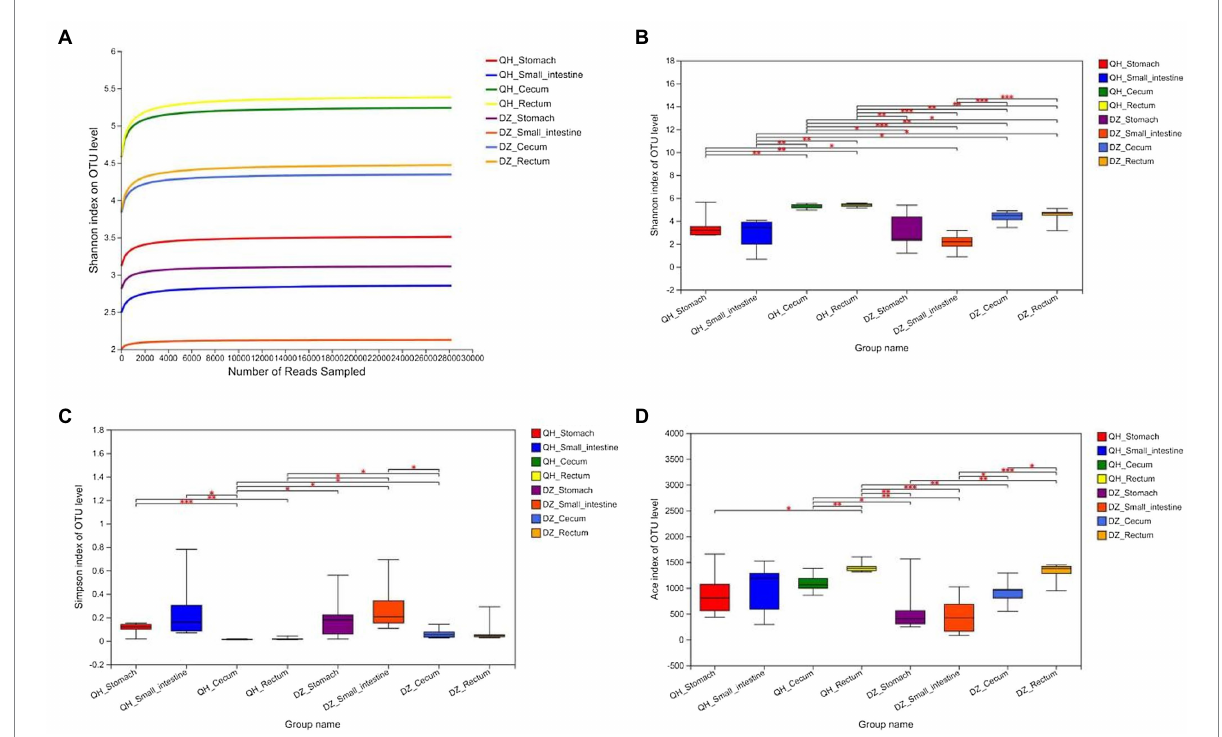
FIGURE 1 Alpha diversity analysis. (A) Sparse curve. Shannon’s exponential curve. The abscissa is the number of sequences; the ordinate is the OTU index. (B–D) Between-group t -test. Type I intervals represent the upper and lower limits of the index. The index difference test chart showed the significant difference between the selected two groups with significant differences (* p < 0.05, ** p < 0.001, *** p < 0.01), the abscissa was the group name, and the ordinate was the index average of each